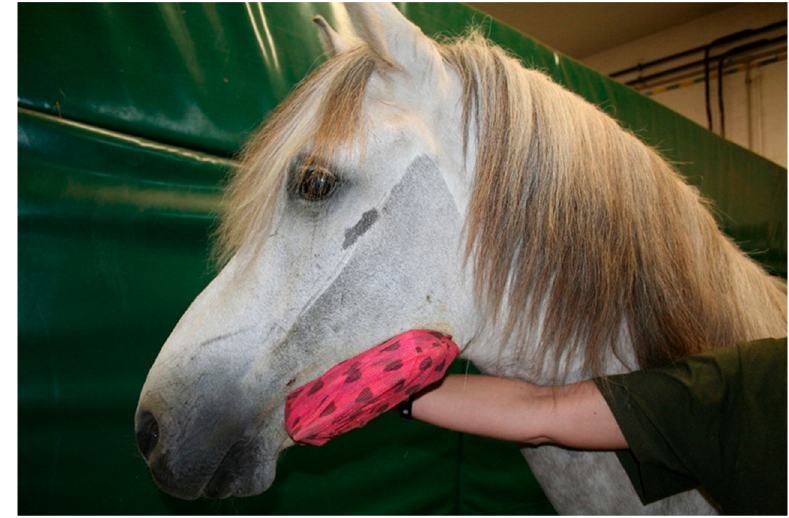
Figure 7. Equine head with unilateral external fixator protected by a bandage.